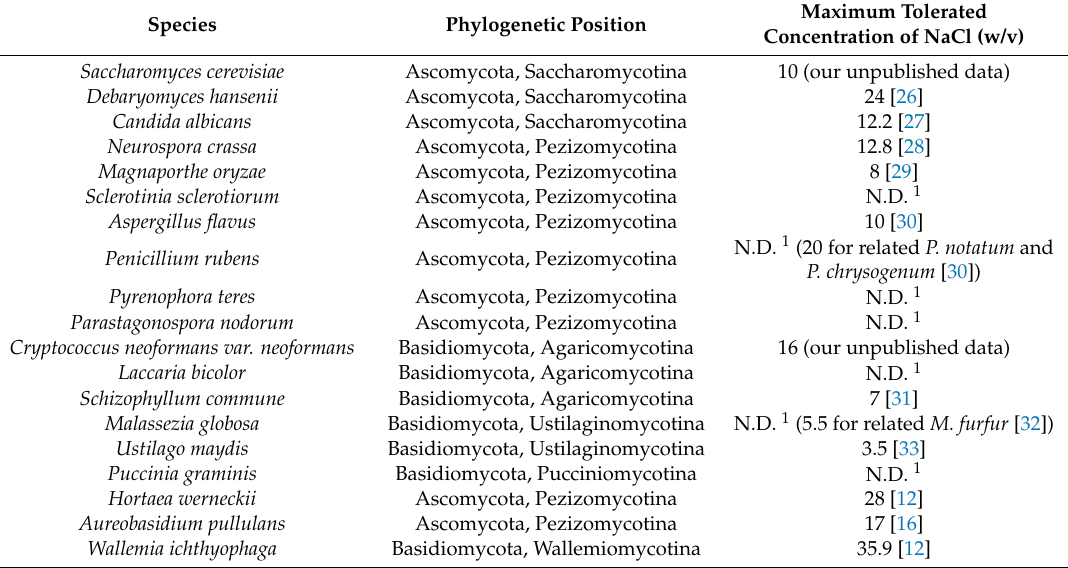
Table 1. Fungal species analyzed in this study and their maximum tolerated NaCl concentrations used in the correlation